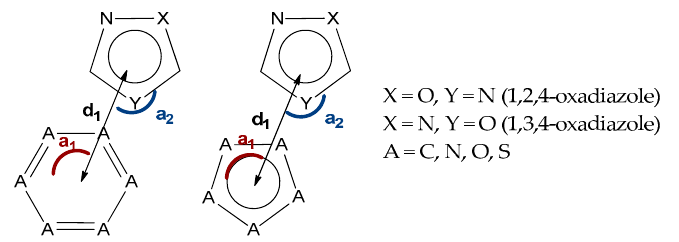
Figure 10. The parameters utilized for processing of the CSD and PDB data.